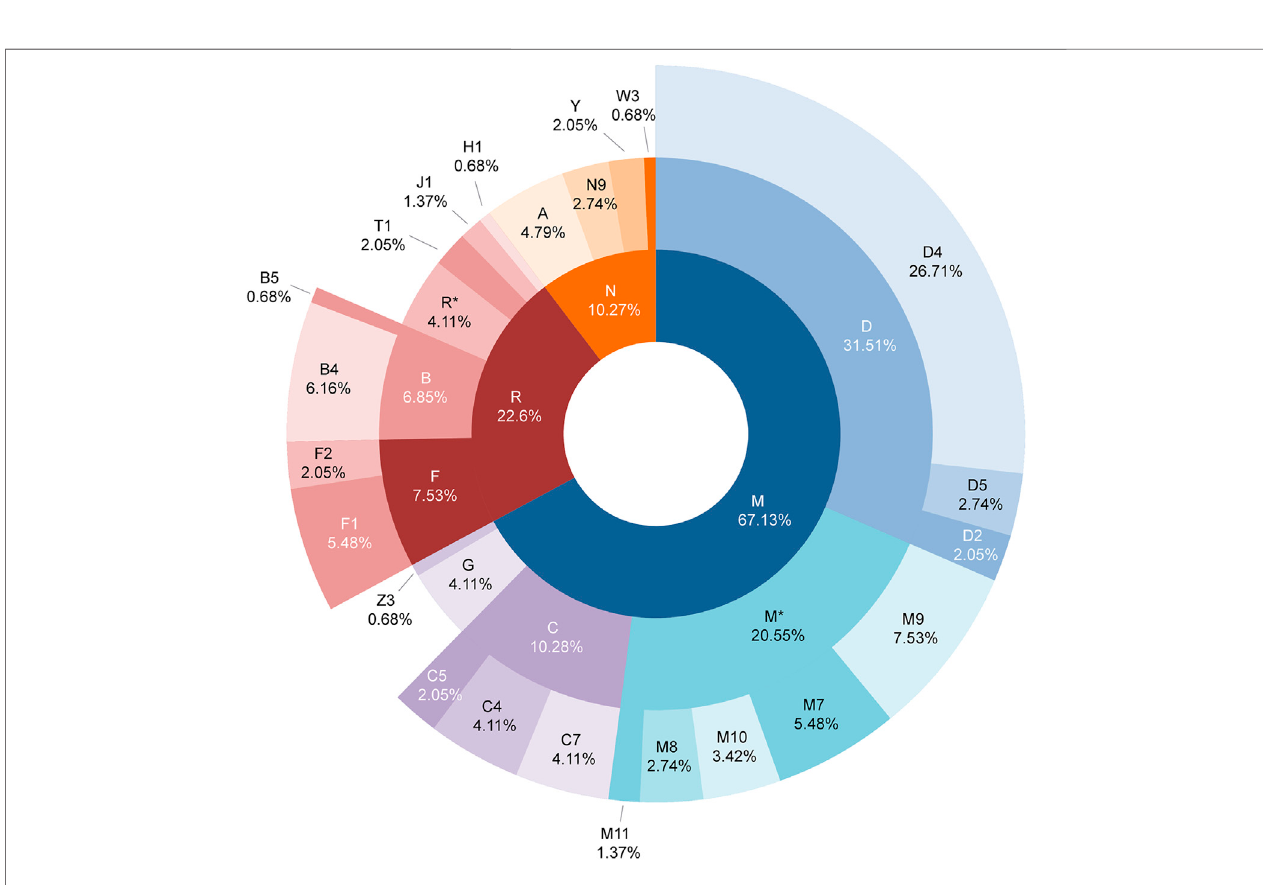
Frontiers in Genetics |